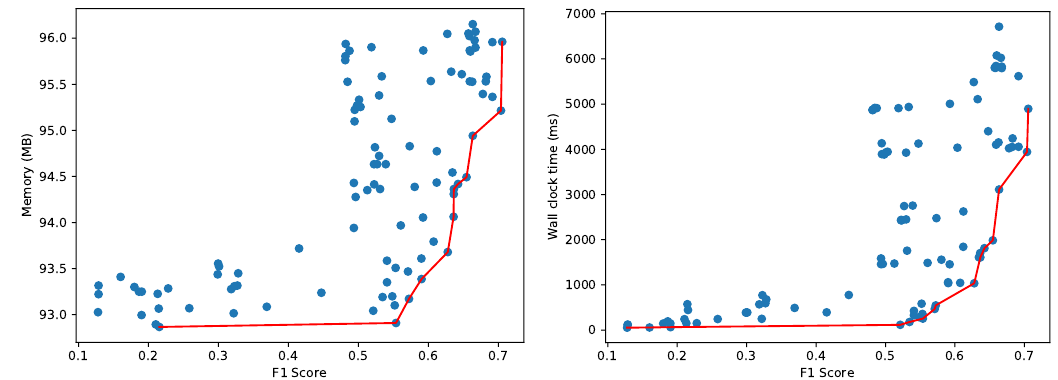
Figure 10. Pareto fronts for memory (left) and wall clock time (right) for the CICIDS 2017 dataset using the One-Class SVM classifier.